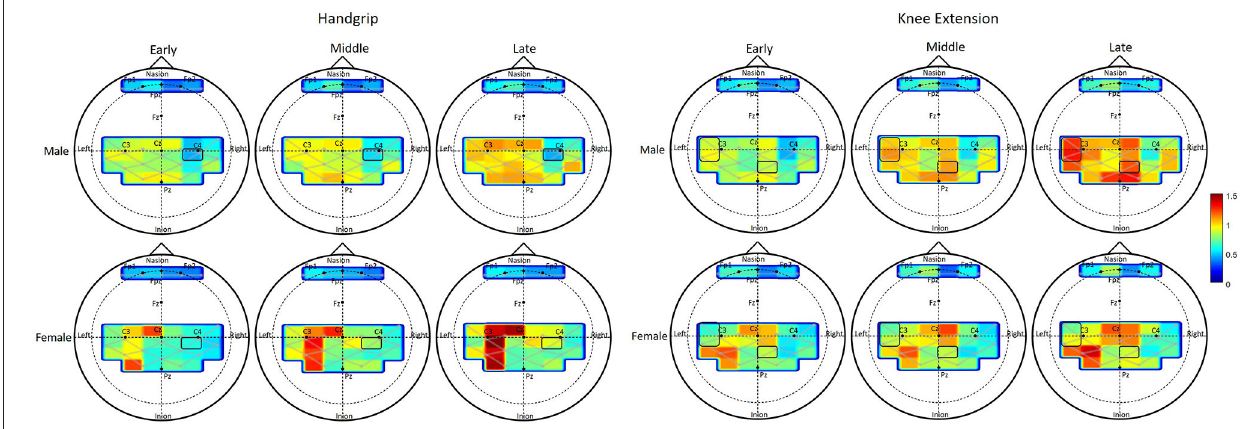
FIGURE 4 | Change of oxygenated blood flow ( 1 HbO) during fatigue development. Each column shows the averaged HbO activation within each phase, early, middle, and late. Top two rows show the HbO activation changes of male and females during handgrip exercise, and bottom two rows show that during knee extension exercise. Each activation map shows the HbO activation of each channel for each group in each phase. Level of activation is displayed as graded color shown in the right side of the figure.